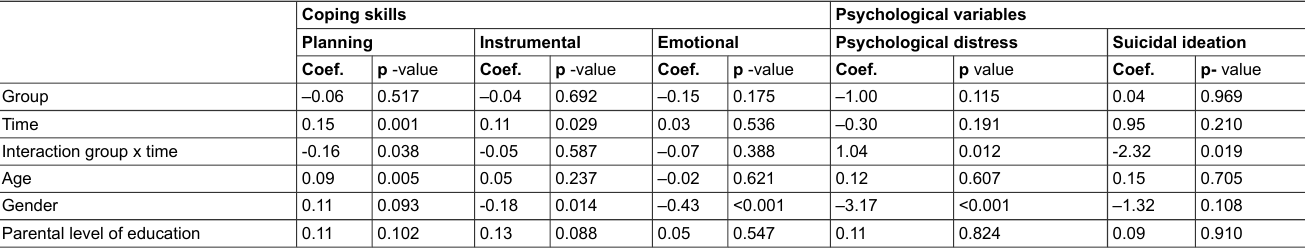
Table 5: Mixed-effect models for exploratory